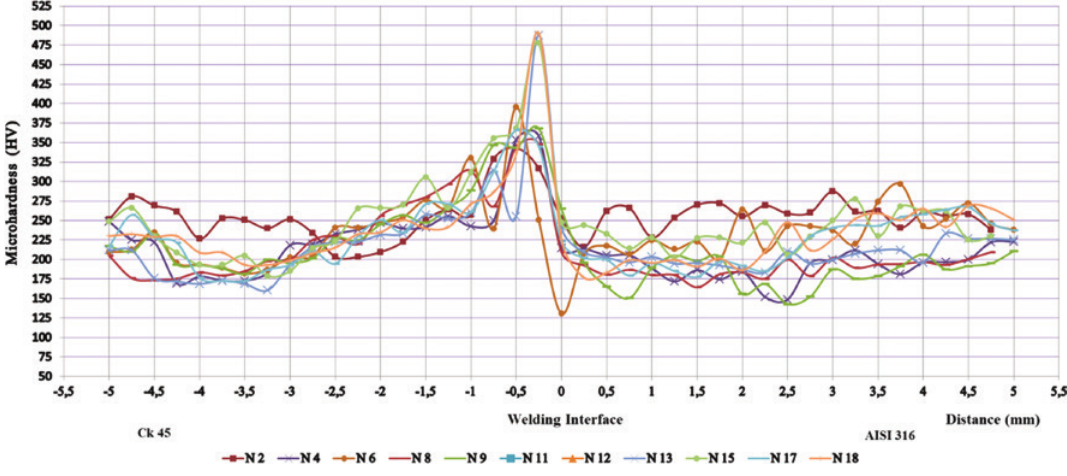
Fig. 12: Hardness variations on horizontal distance